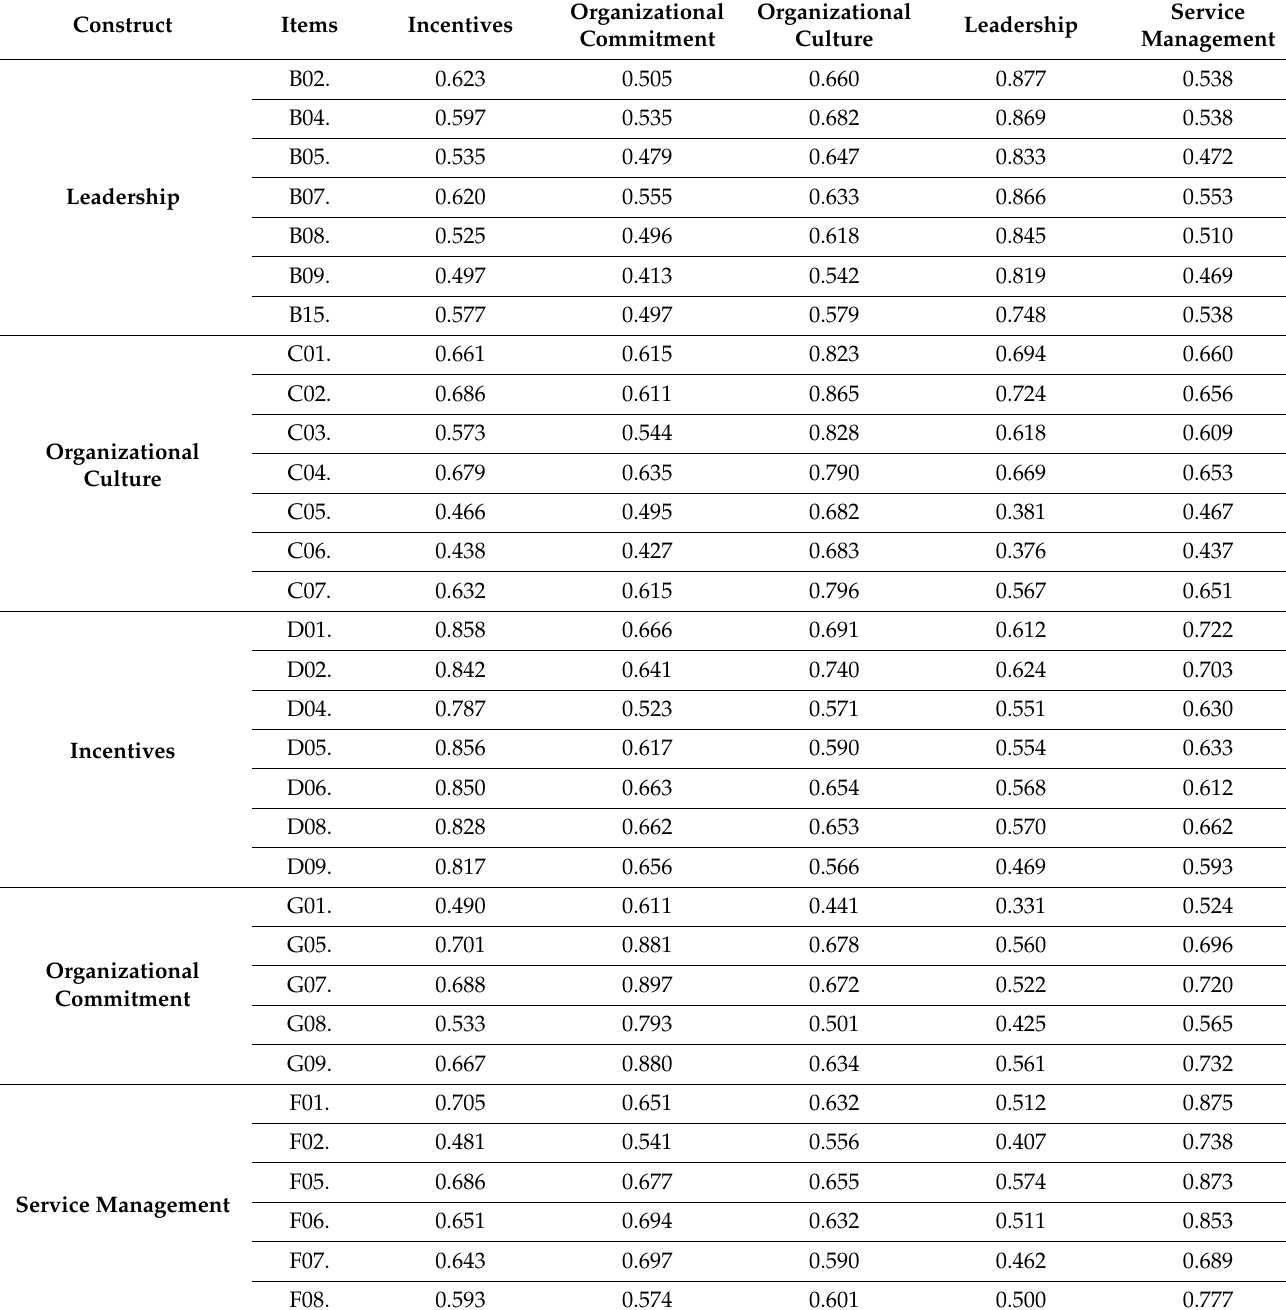
Table 3. Cross loading of each